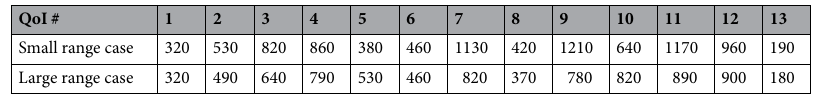
Table 3. Number of terms retained in the OMP method for each